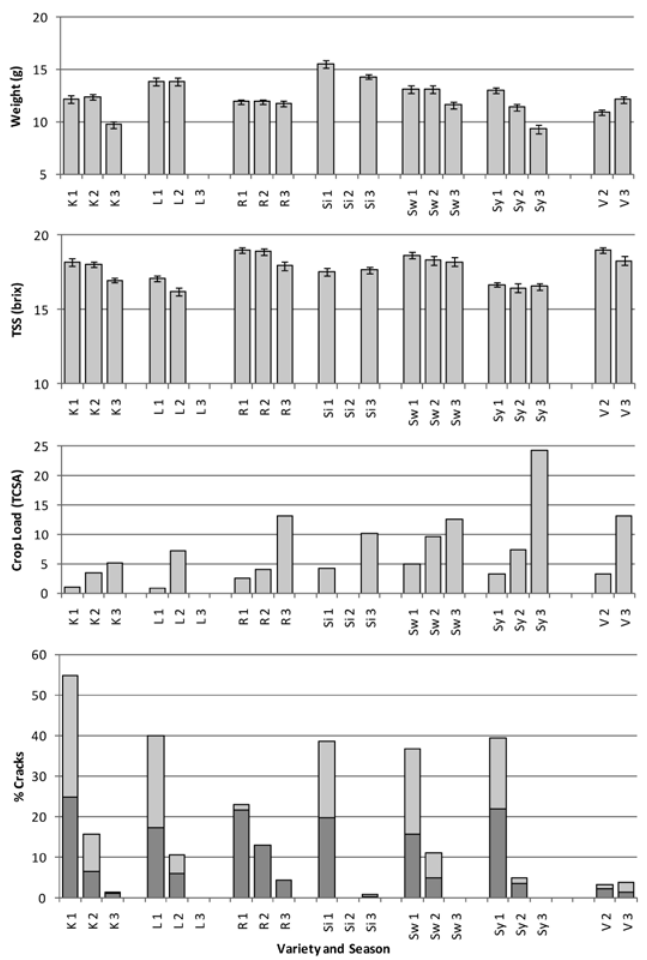
Fig. 6 - Mean fruit weight and total soluble solids for seven variet- ies over three seasons (error bars represent SEM, n = 30) with mean crop load levels (n = 3) and cracking incidence for the same varieties and seasons. For cracking incidence, expressed as percentage of total yield, columns represent total incidence, where light areas represent incidence of cuticular-cracked fruit, and dark areas represent incidence of side-cracked fruit. Hori- zontal axis labels represent variety by letter (K - Kordia, L- Lapin, R - Regina, Si - Simone, Sw - Sweetheart, Sy - Sylvia, V - Van) and season by number (1 - 2005/06, 2 -2006/07, 3